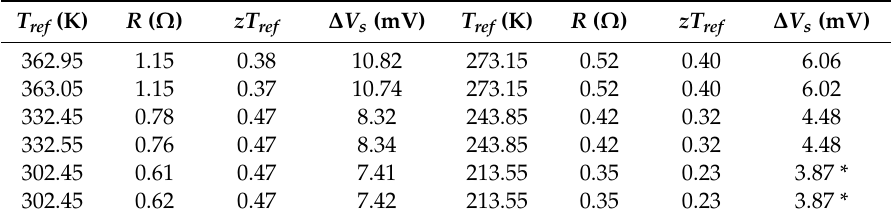
Table 5. Peltier module b: p - n series resistance, the figure of merit, and Seebeck voltage ( I = 25